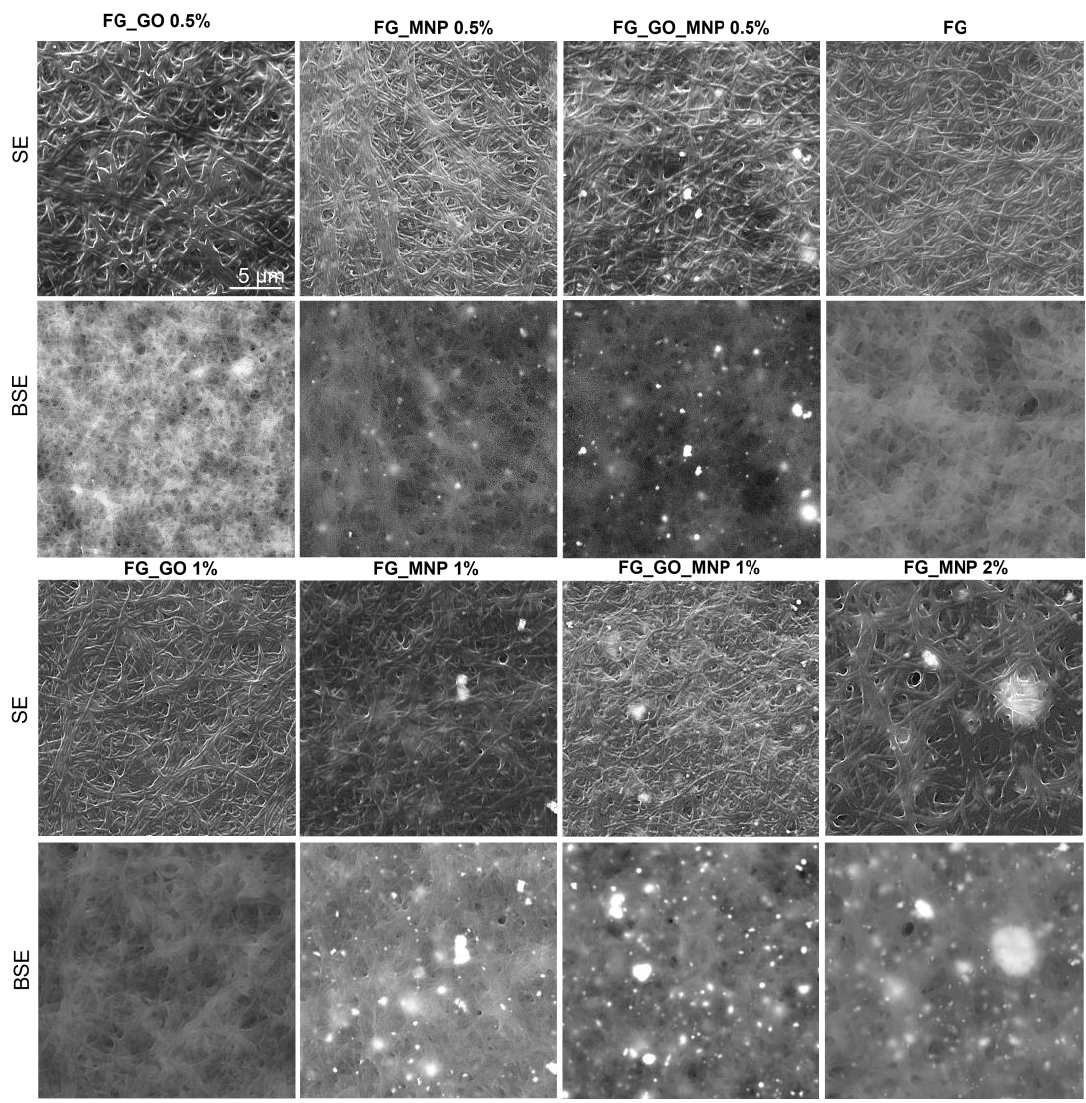
Figure 2. Representative SEM images for all samples after crosslinking (10 kX magnification). The scale bar of 5 μm is applicable for all images .